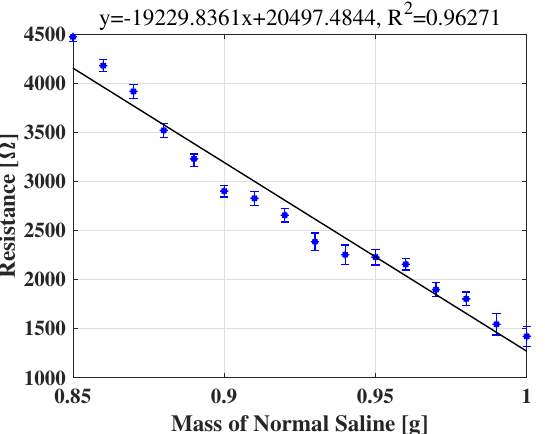
Figure 10. The relationship between the mass of the normal saline and the resistance of the